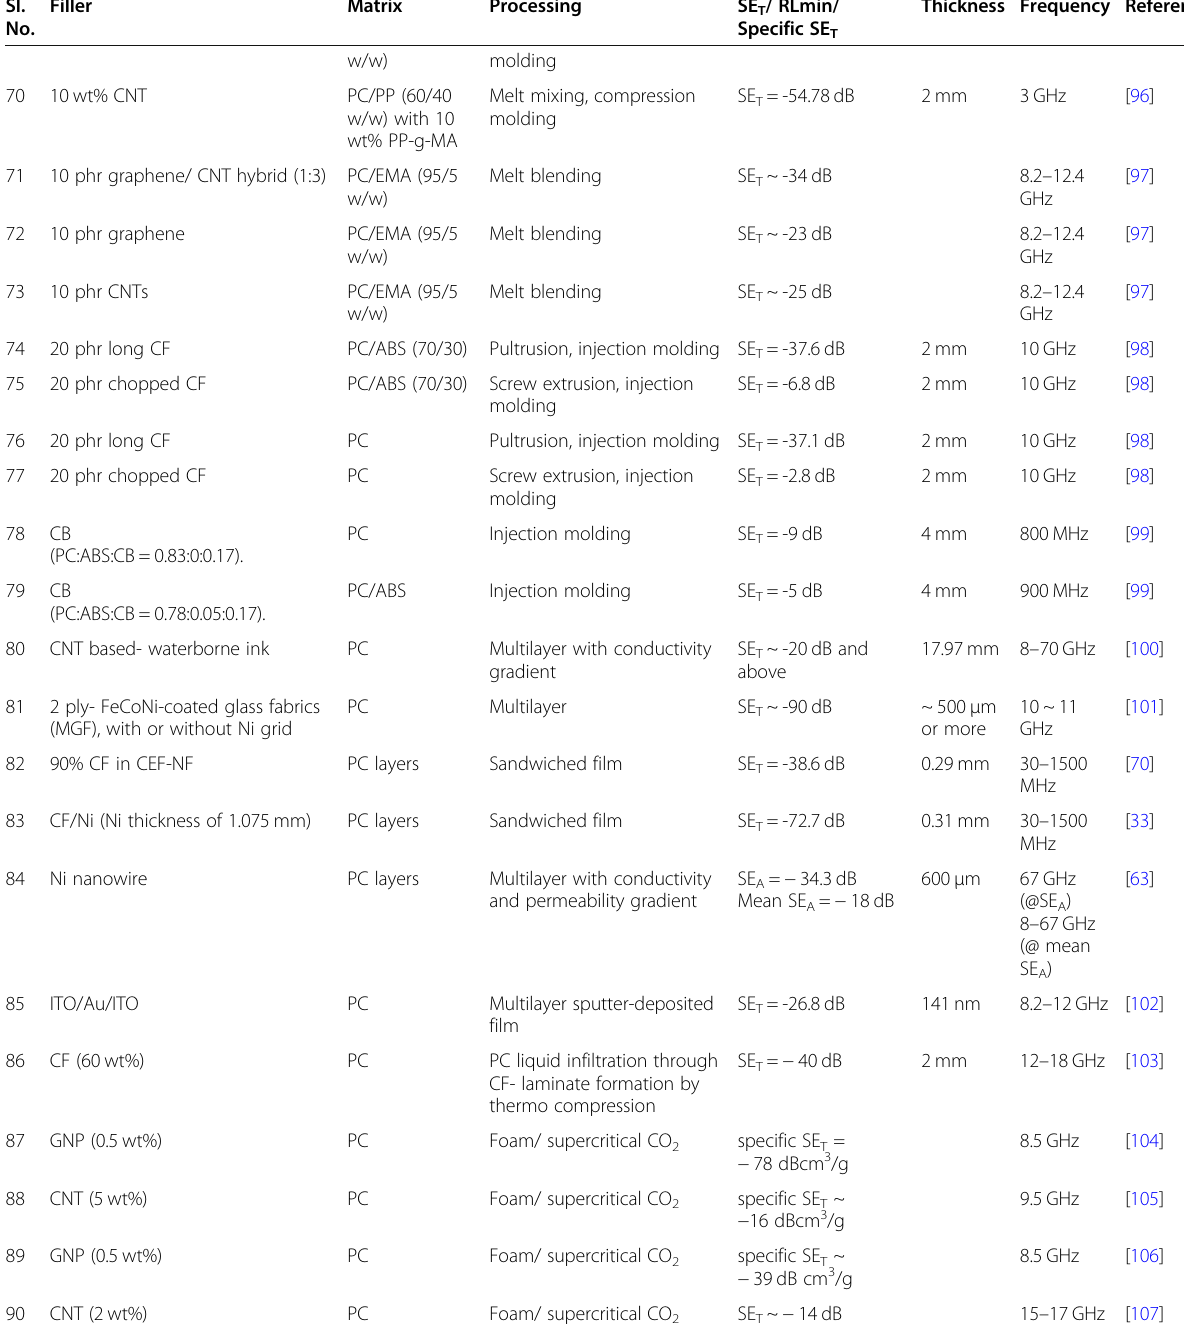
Table 4 List of PC-based hybrid structure for EMI shielding applications (Continued) Sl. No.